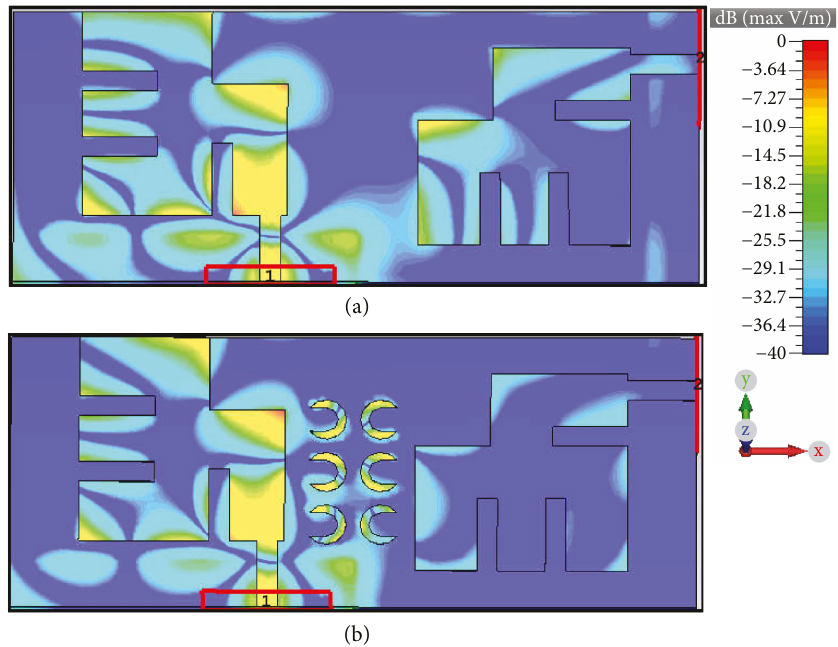
Figure 19: Surface current distribution (a) without and (b) with CSR matrix